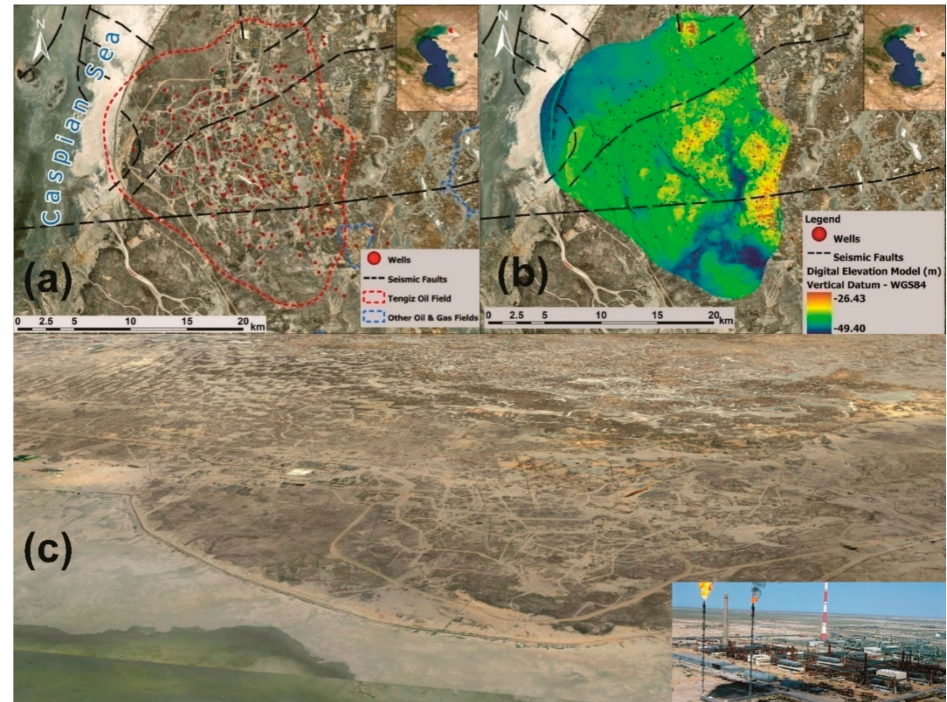
Figure 1. ( a ) Tengiz oilfield with the representation of wells; ( b ) Elevation model of the Tengiz oilfield; ( c ) Oblique aerial view of the Tengiz